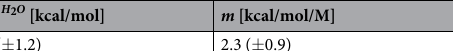
∆ G H O 2 [kcal/mol] m [kcal/mol/M]